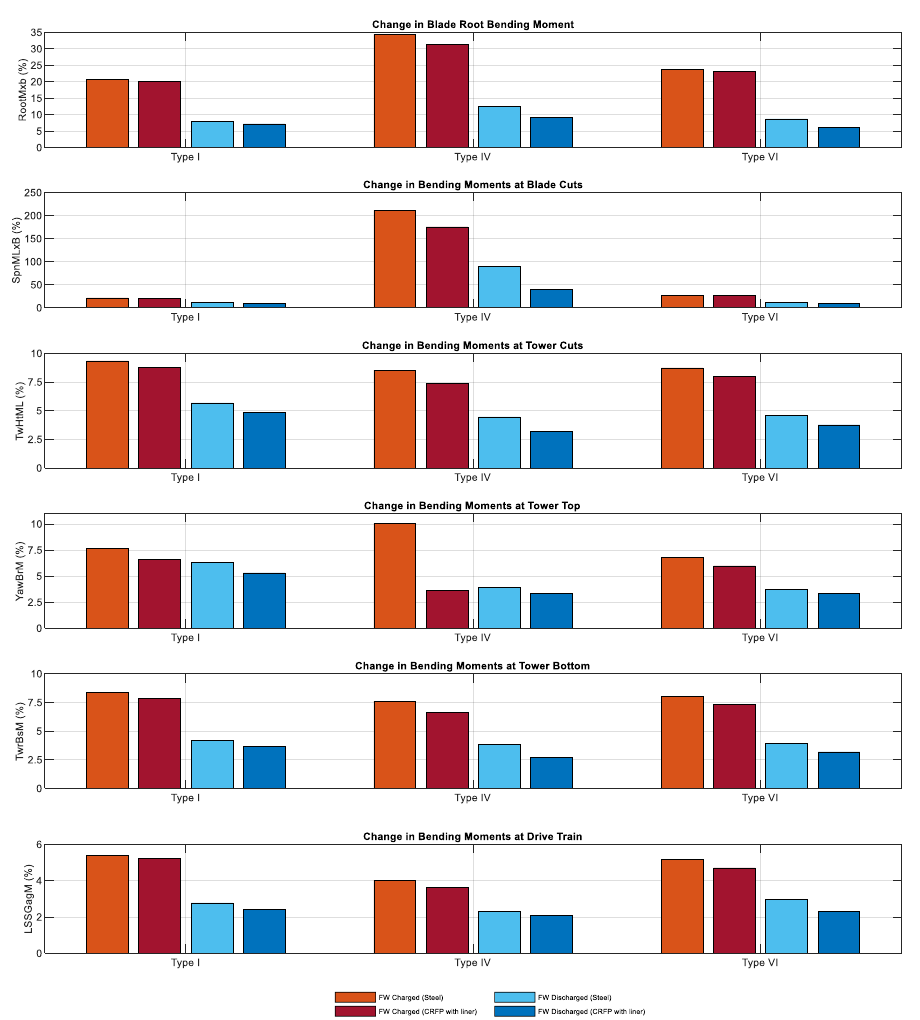
Figure 11. Comparison of changes in ultimate loads in (from top to bottom) blade root bending moment, bending moments at blade cuts, bending moments at tower top, bending moments at tower bottom, and bending moments at drive train, between steel accumulator and CFRP with metal liner accumulator for FW types I, IV, and VI in charged (red) and discharged (blue) status, both with respect to the ultimate loads of the original WT without FW system.